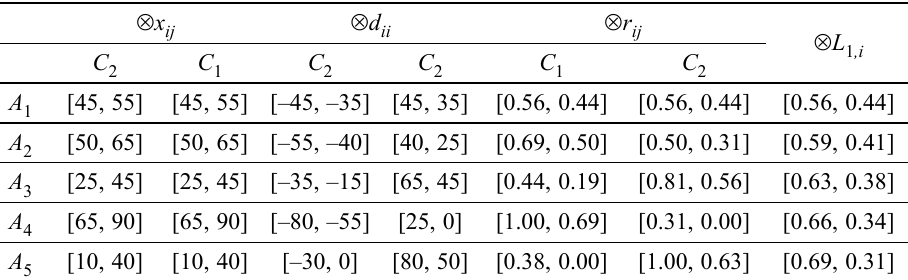
Table 14. The results of calculations in the case of crisp ideal point